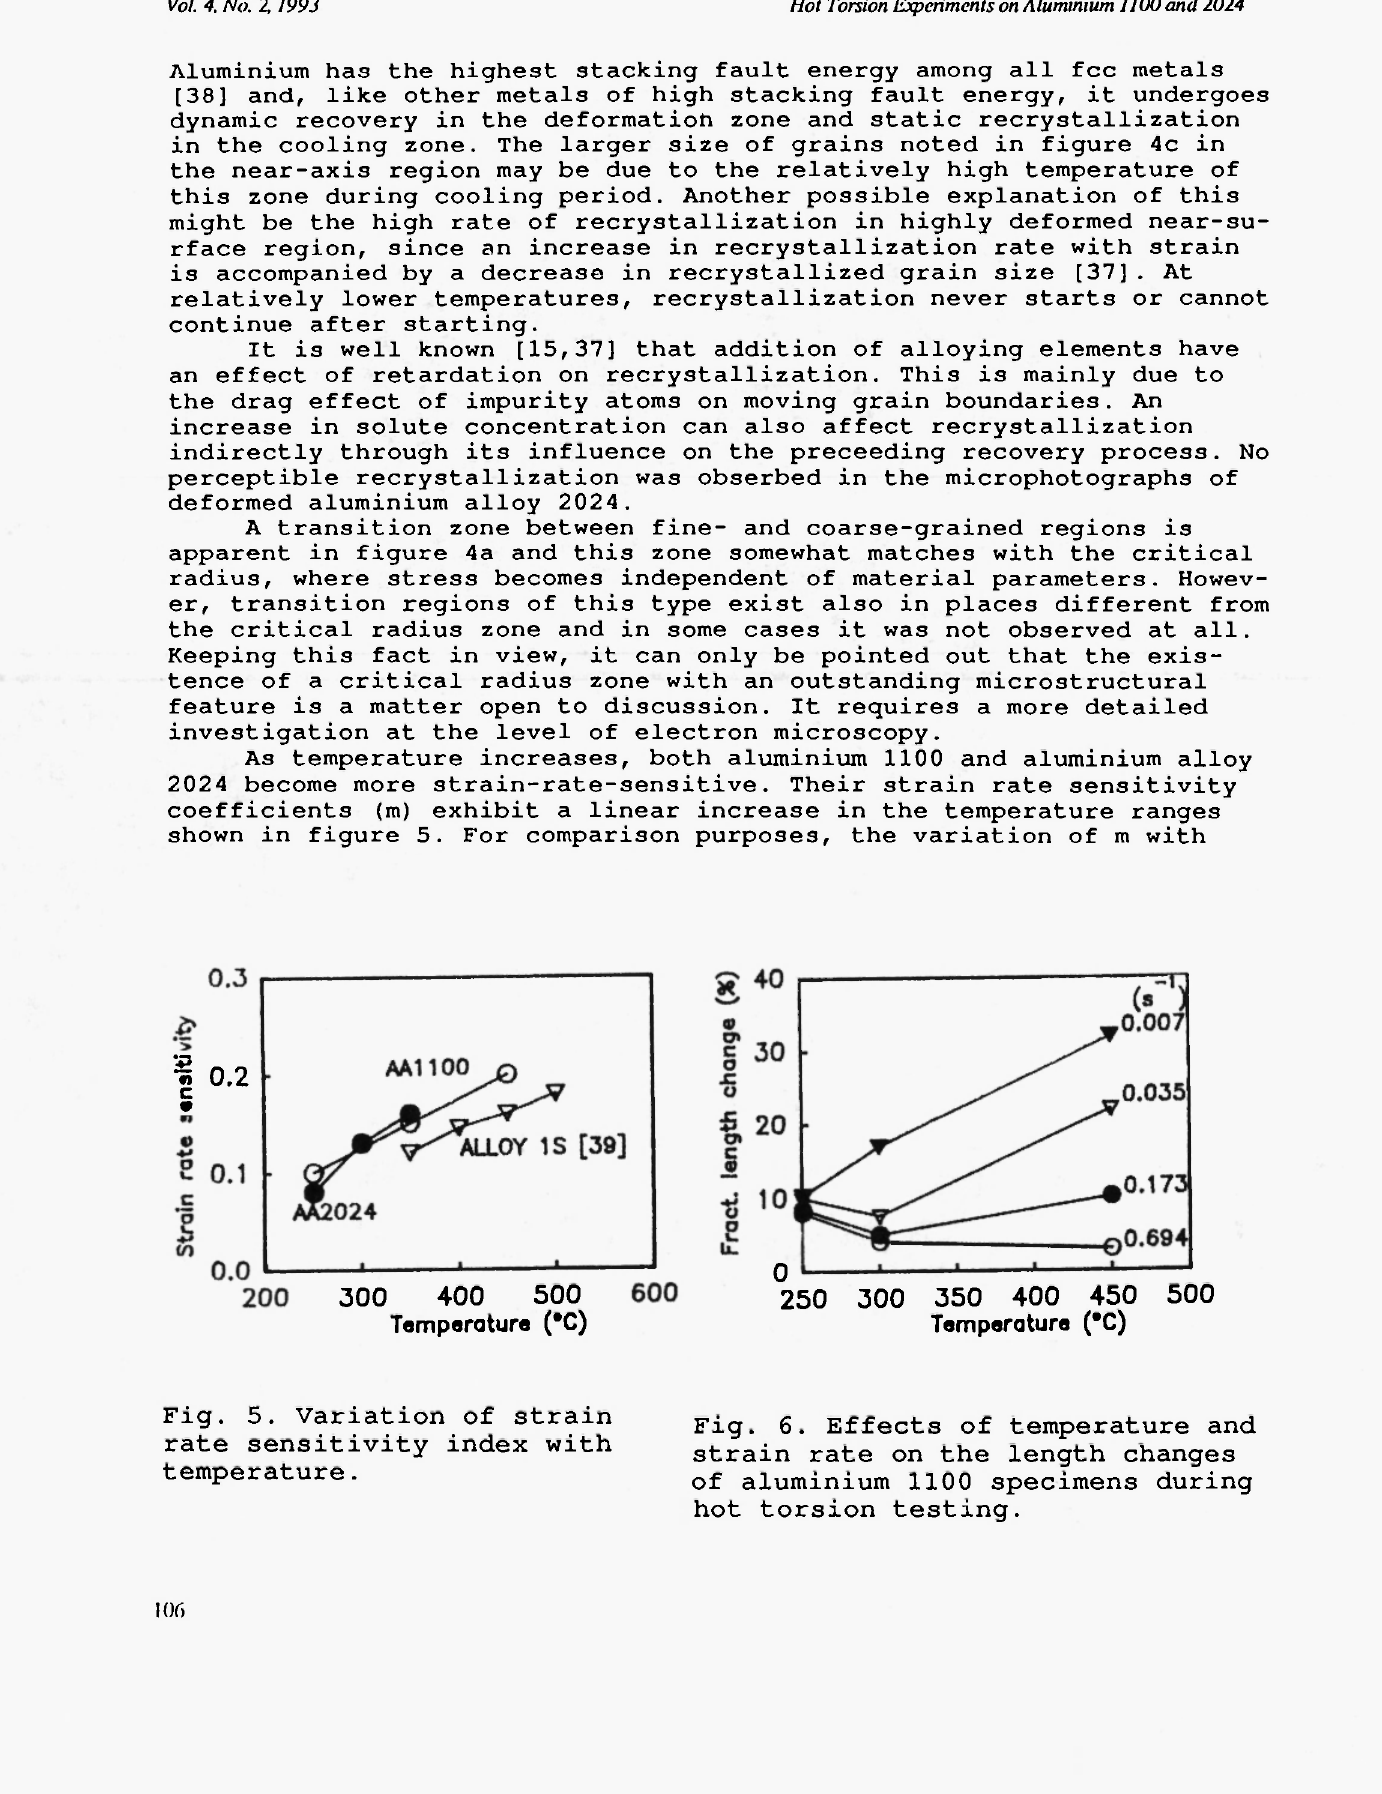
Fig. 5. Variation of strain rate sensitivity index with temperature.